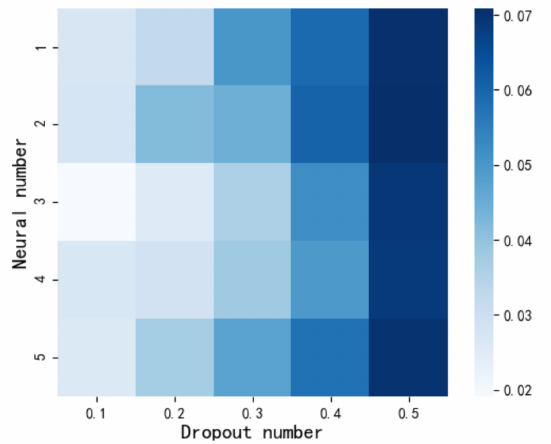
Figure 7. Results of a grid search with two